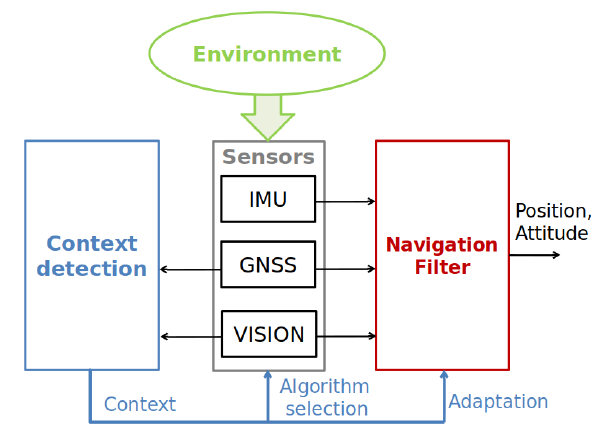
Figure 1. Context-aware adaptive navigation